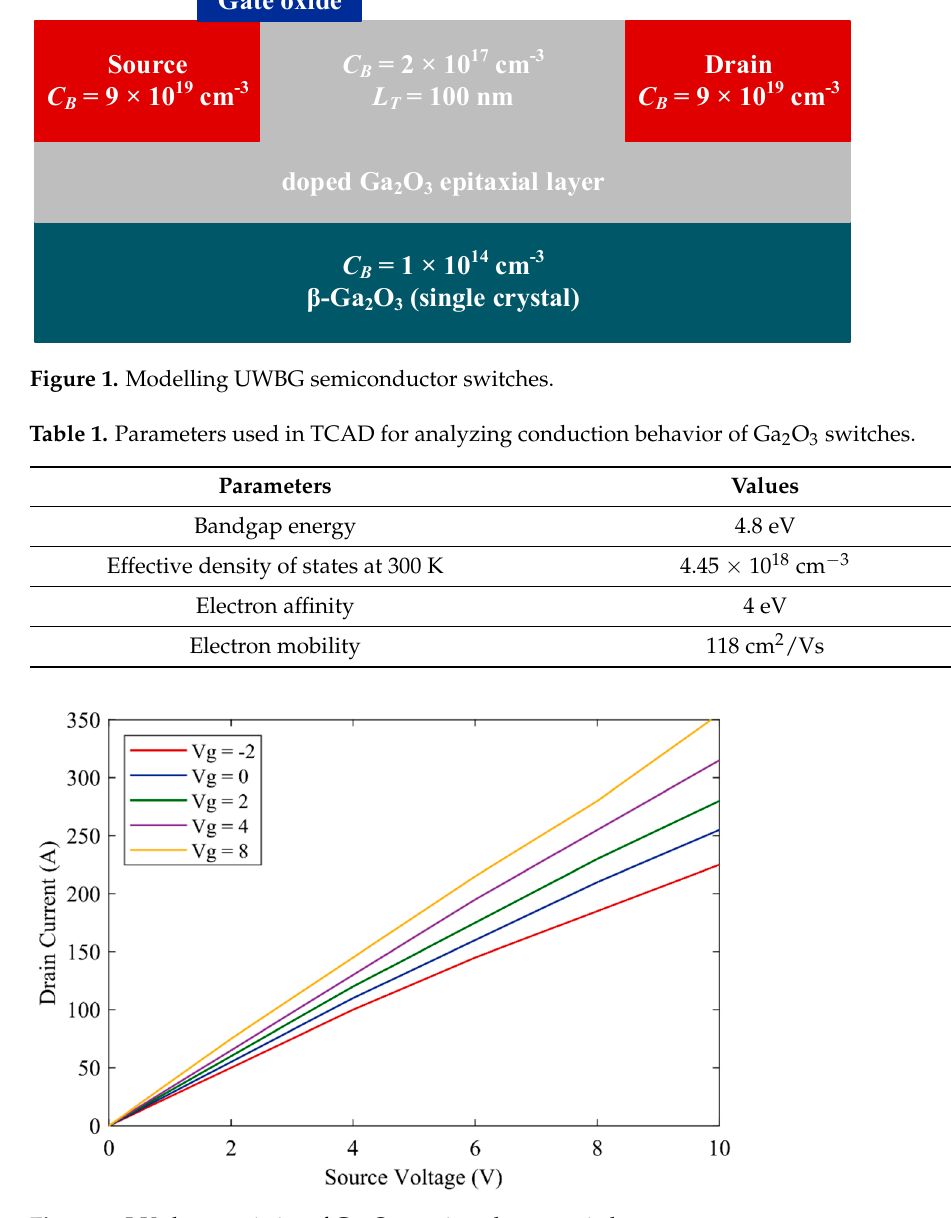
Table 1. Parameters used in TCAD for analyzing conduction behavior of Ga 2 O 3 switches. Parameters